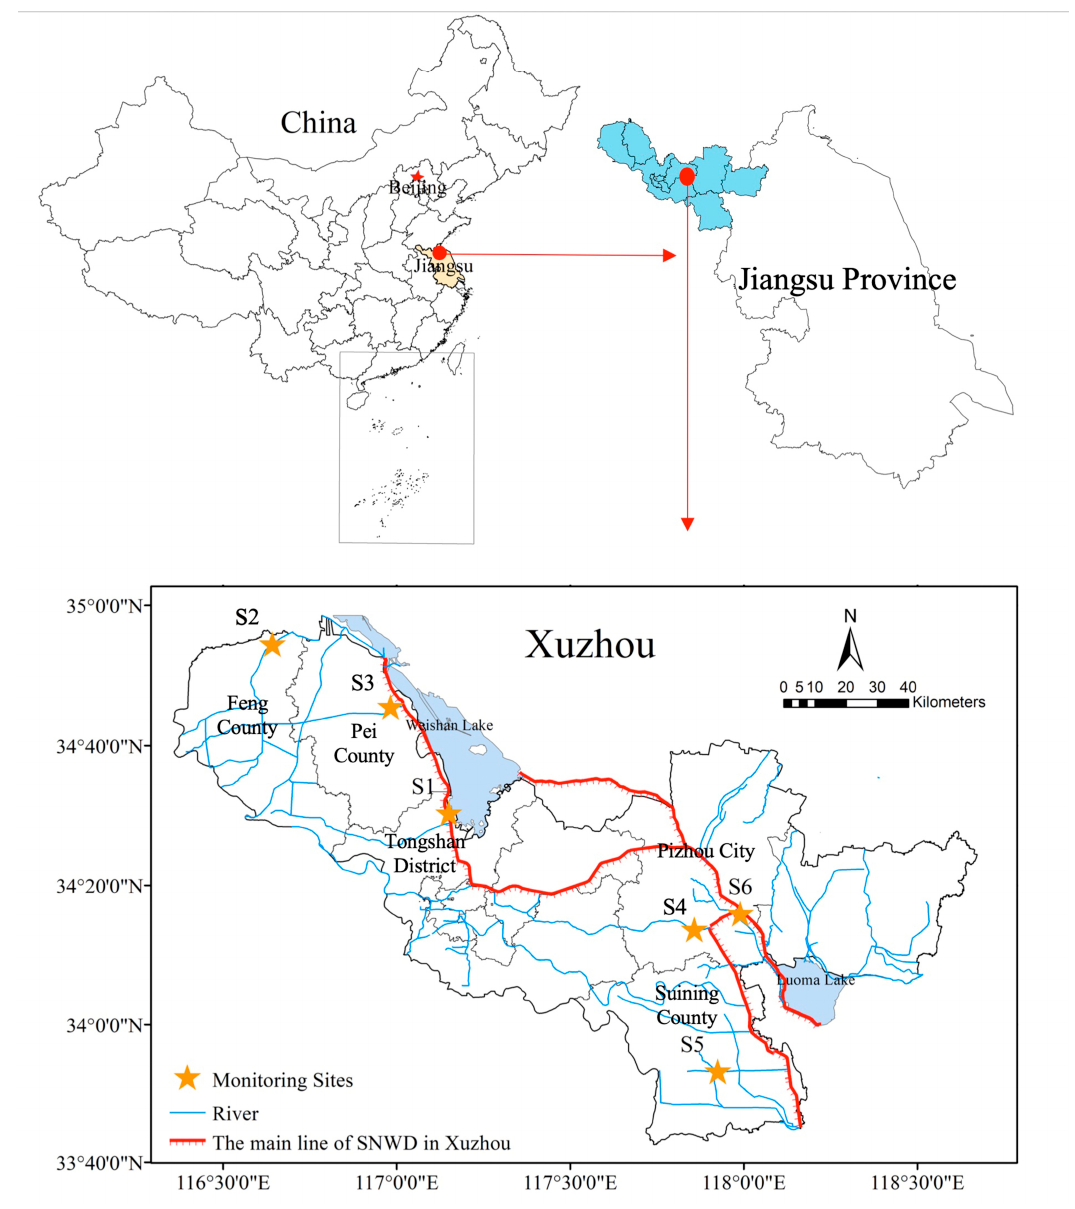
Figure 1. Map of the state-controlled monitoring sites in Xuzhou section.